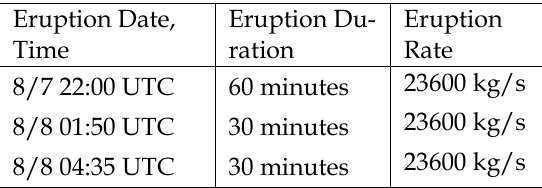
Table 2: Eruption times and durations